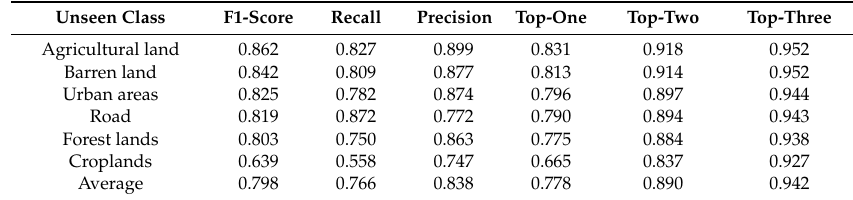
Table 6. Retrieved labels for unseen classes for the first test dataset (Cameron